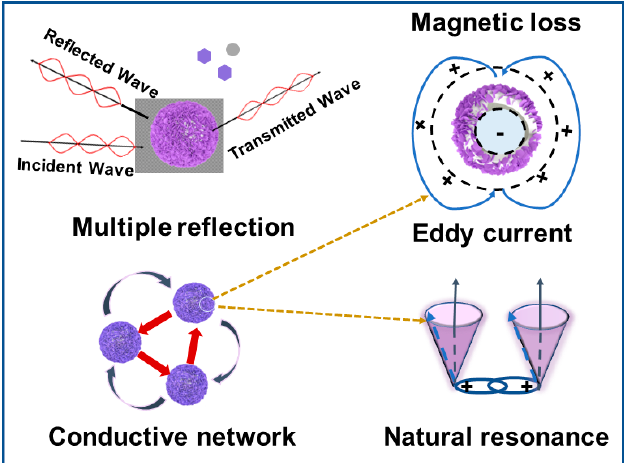
Figure 6. Microwave absorption mechanisms of SiO 2 @NiFe LDH.